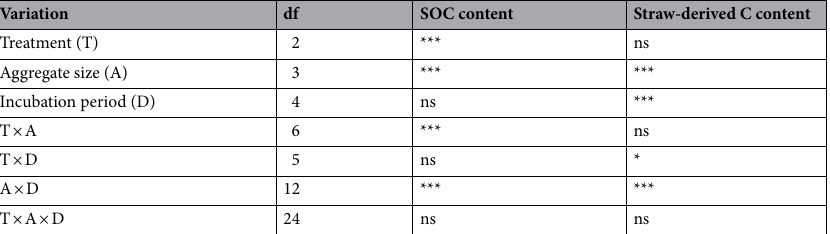
Table 1. Analysis of variance (ANOVA) results on interactions the effects of treatment, aggregate size, incubation period on SOC content and straw-derived C content. * and *** indicate significant differences at P < 0.05 and P < 0.001 level, respectively. ns represents no statistical significance at the P < 0.05